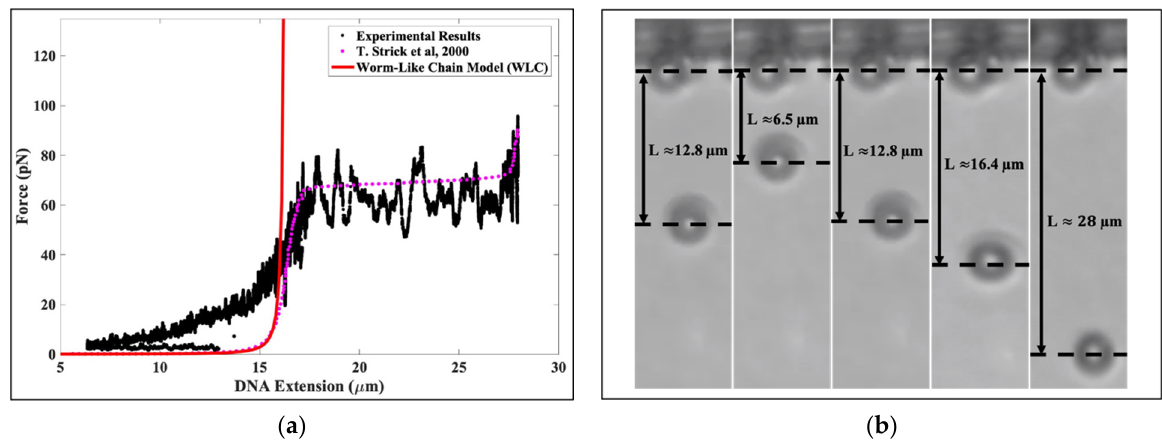
Figure 1. ( a ) The force versus extension for a DNA-histone complex under tension. The solid black circles represent our experimental results. The solid pink circles represent the experimental force–extension data for λ -DNA obtained using optical tweezers—see Ref. [26]. The solid red line represents the force–extension behavior of a worm-like chain model under tension. ( b ) A total of five snapshots from an experiment showing the compaction and force-induced decompaction of histones bound to a single DNA tether. From left to right, the first snapshot shows naked DNA (DNA before introduction of histones) with an end-to-end extension of ≈ 12.8 μ m corresponding to a force of ≈ 2.2 pN. The second snapshot shows that the extension of the λ -DNA has reduced to ≈ 6.5 μ m after binding by histones at a force of ≈ 2.5 pN. The third snapshot shows that the tether has re-extended to ≈ 12.8 μ m at a force of ≈ 16.4 pN. The fourth snapshot shows that λ -DNA has reached its contour length of ≈ 16.4 μ m (here, the force is ≈ 40 pN.) The fifth snapshot shows the λ -DNA beyond the overstretching transition, where it has stretched to ≈ 28 μ m; this corresponds to a force of ≈ 74 pN.